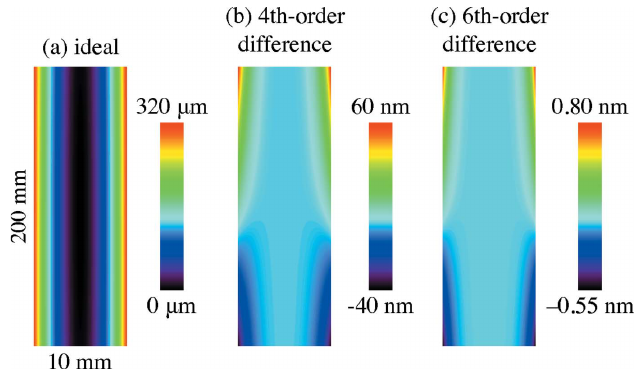
Figure 6 Comparison of the ideal surface to two polynomial expansions. ( a ) Ideal paraboloid, computed for q = 4 m, (cid:2) = 5 mrad. ( b ) Point-by-point comparison with a series expansion up to ( i + j ) (cid:5) 4. ( c ) Comparison with a series expansion up to ( i + j ) (cid:5) 6. Note that the rendering of the domain is not